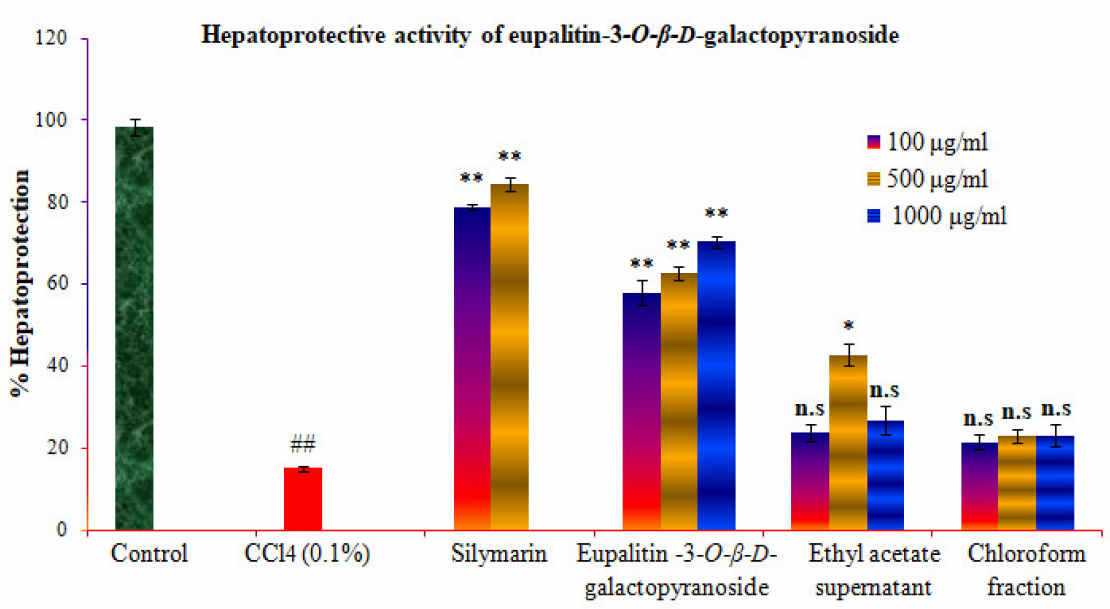
Figure 5. Effect of the eupalitin-3- O - β - D -galactopyranoside on CCl 4 -induced toxicity in HepG2 cells. HepG2 cells were incubated in the presence/absence of various compounds for 2h prior to treatment with CCl 4 (0.1%) for 2h. Thereafter, the cells were processed for the MTT assay. The results are expressed as mean ± SEM. ## Carbon tetrachloride toxic group significant, “n.s” p > 0.05, ** p < 0.01, * p < 0.05 compared to the control group. Table 3. Effect of eupalitin-3- O- β -D -galactopyranoside and standard silymarin on CCl 4 induced